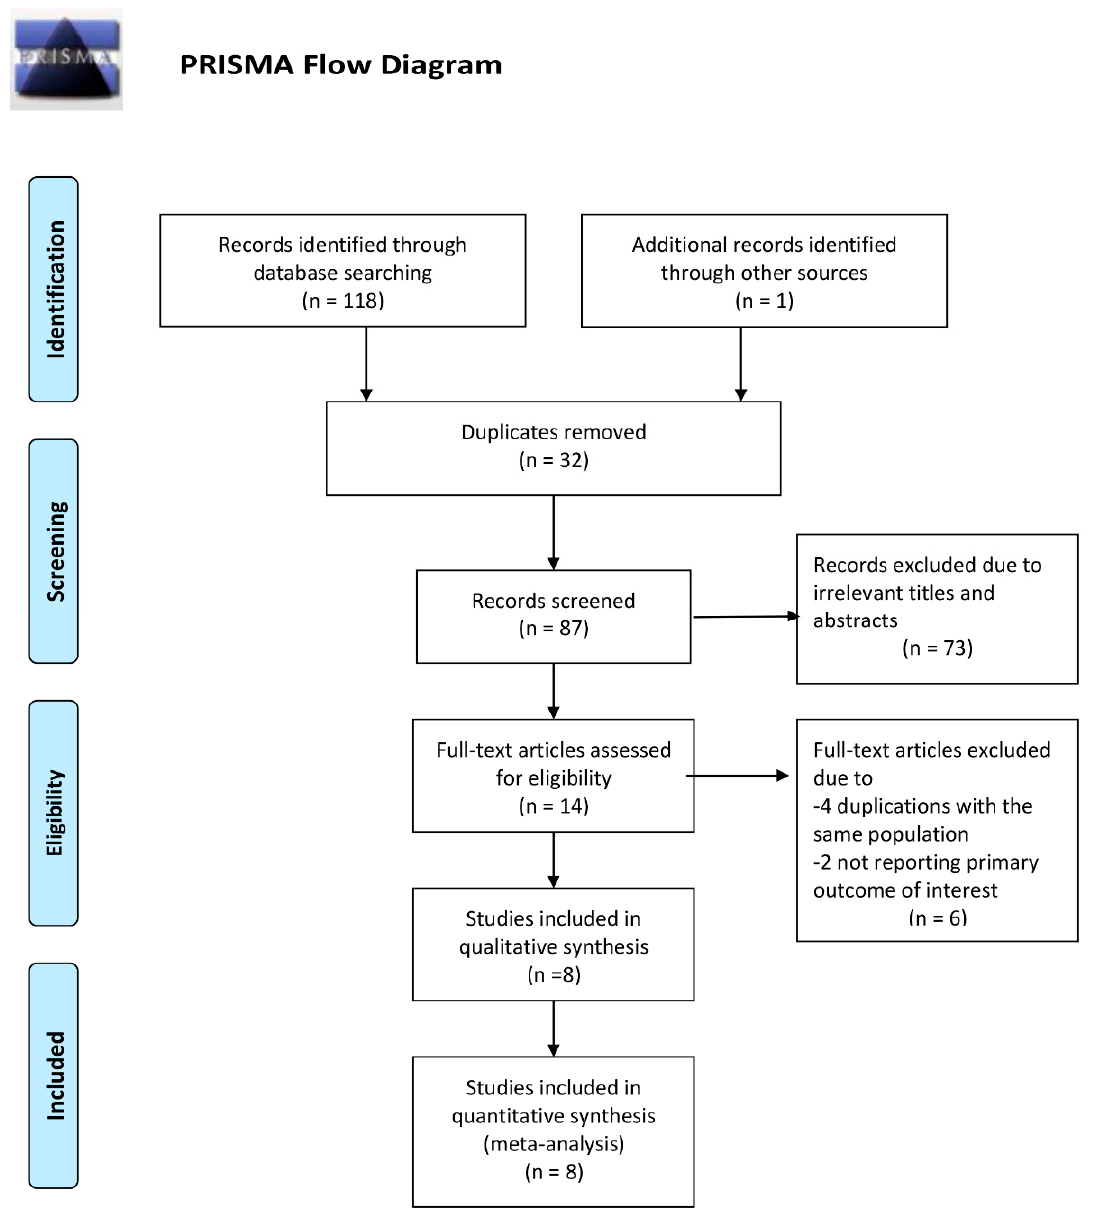
Figure 1. Flow diagram for study selection.